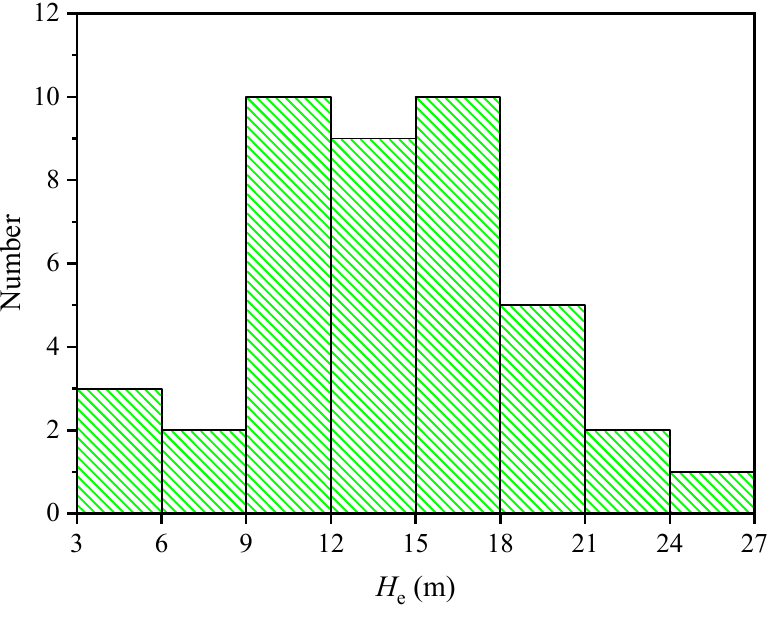
Figure 2. Histogram of deep excavation depth H e .